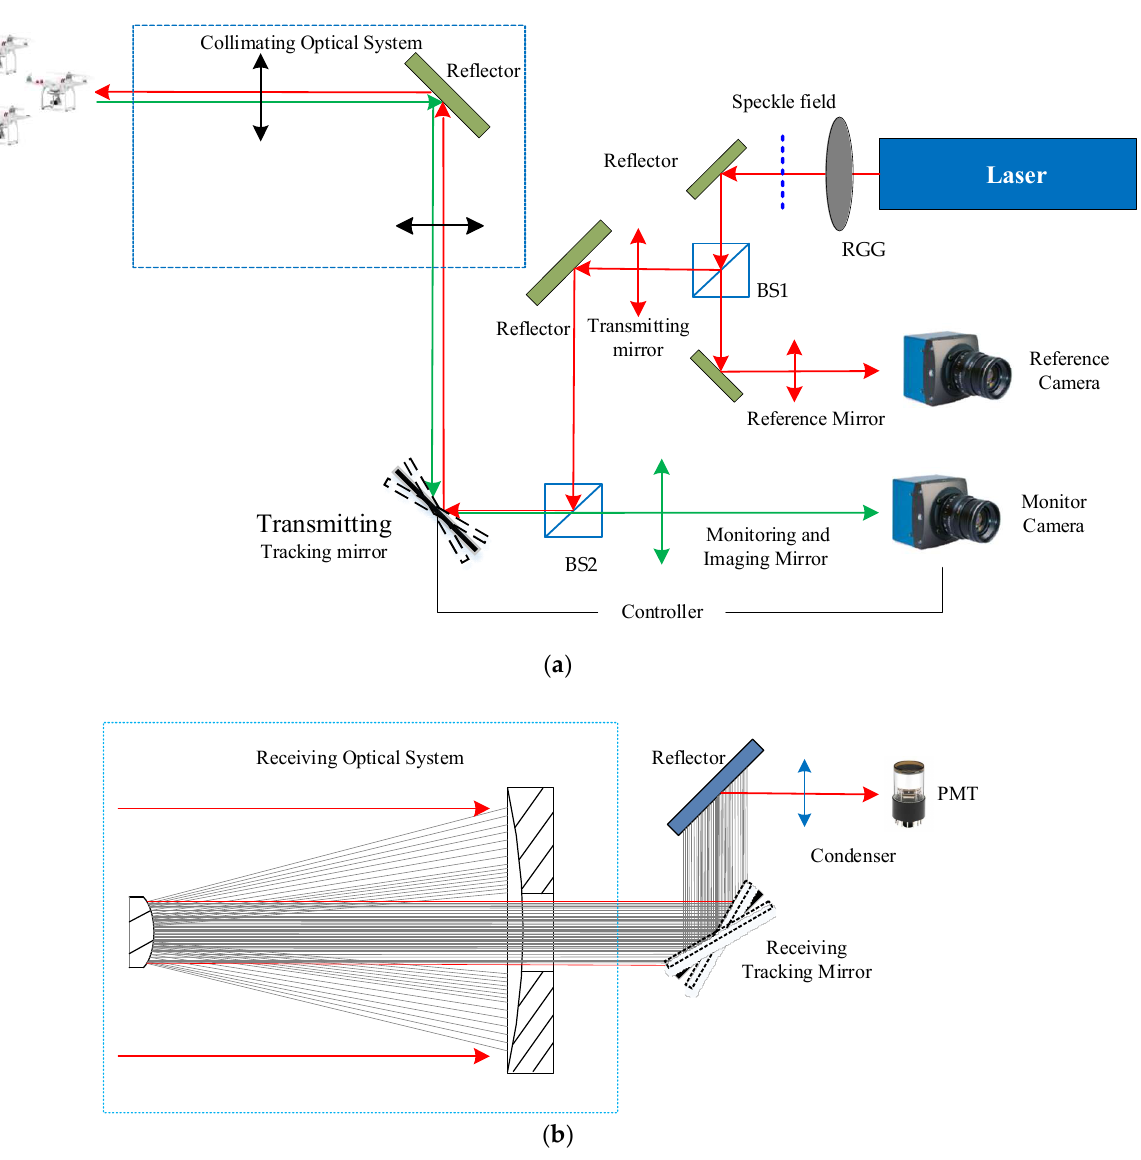
Figure 6. Experimental platform’s schematic diagram of dual-FSM 3D GISC LiDAR tracking control system (PMT: photon multiplier tube, BS: beam splitter, RGG: rotating ground glass). ( a ) Transmitting system’s optical path structure; ( b ) receiving system’s optical path structure.